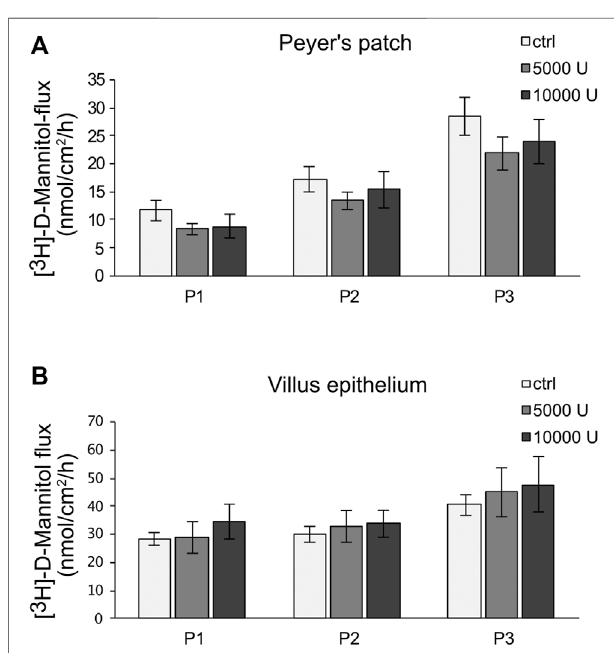
FIGURE 3 | Time-dependent effect of TNF (5000 U/ml) on PP (A) or VE (B) .Thecytokinewasaddedtotheserosalsideofthetissues,andTER-values were recorded for up to 10 h. Data are shown as the percentage of initial resistance ± SEM ( n = 8 – 23, * p < 0.05).